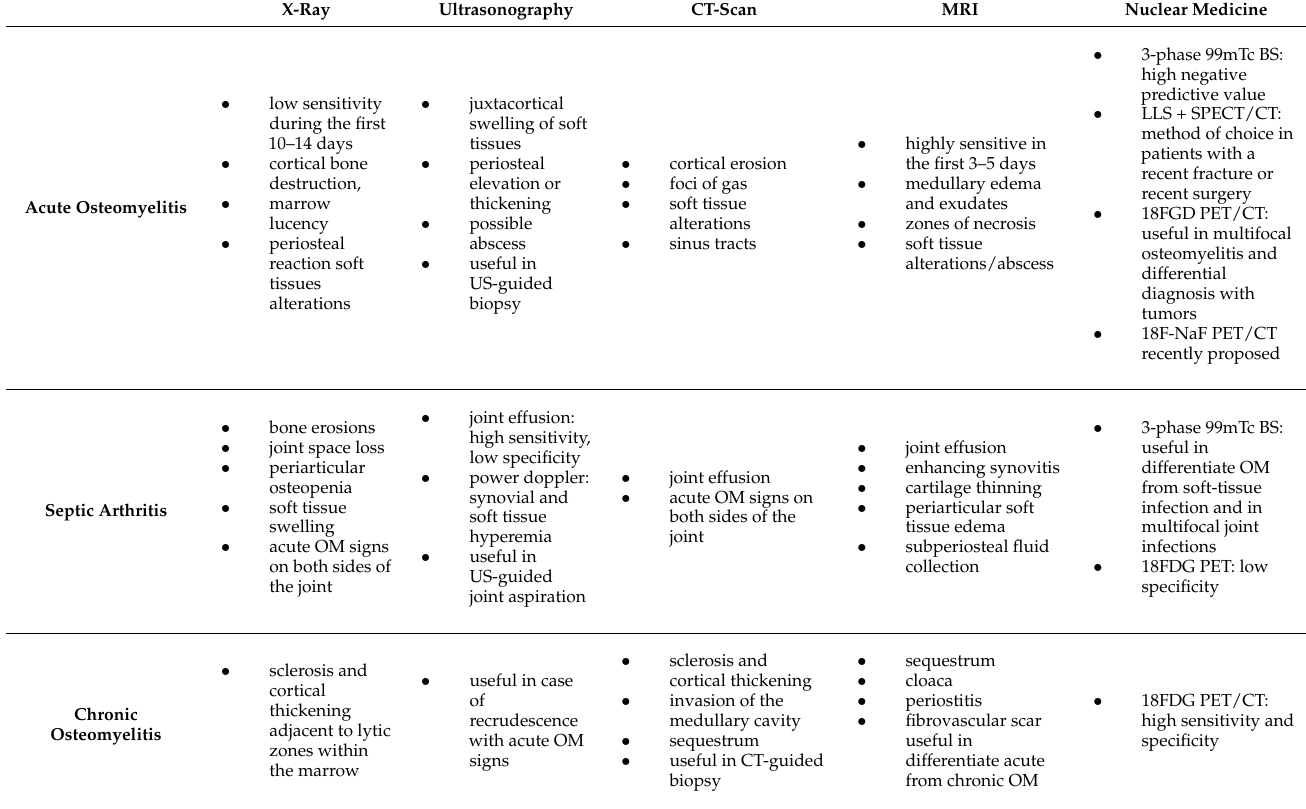
Table 1. A multidisciplinary team (MDT) evaluation which includes radiologist, orthopedic surgeon, infectious disease specialist, and microbiologist is essential for a correct diagnosis of